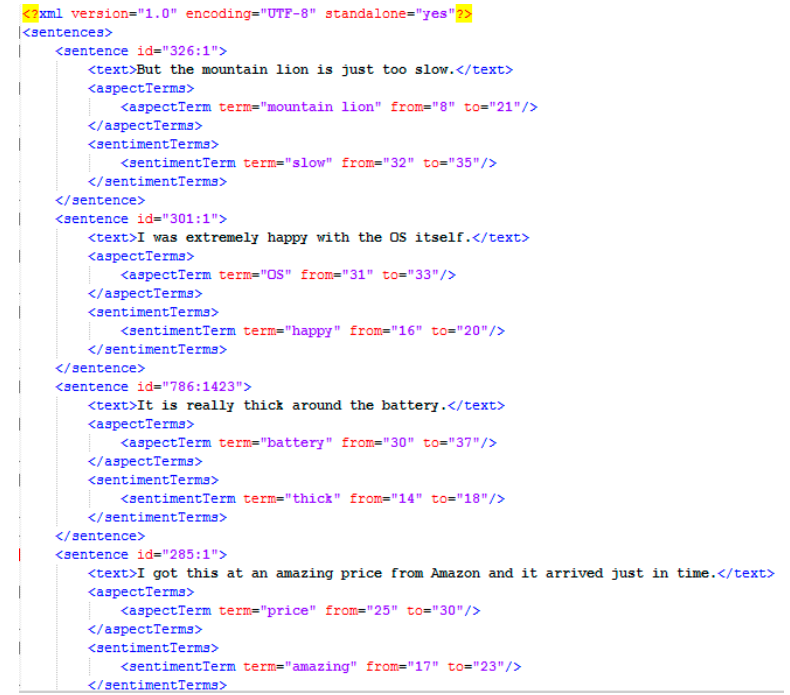
Figure 4. Annotated testing dataset for the laptop domain.